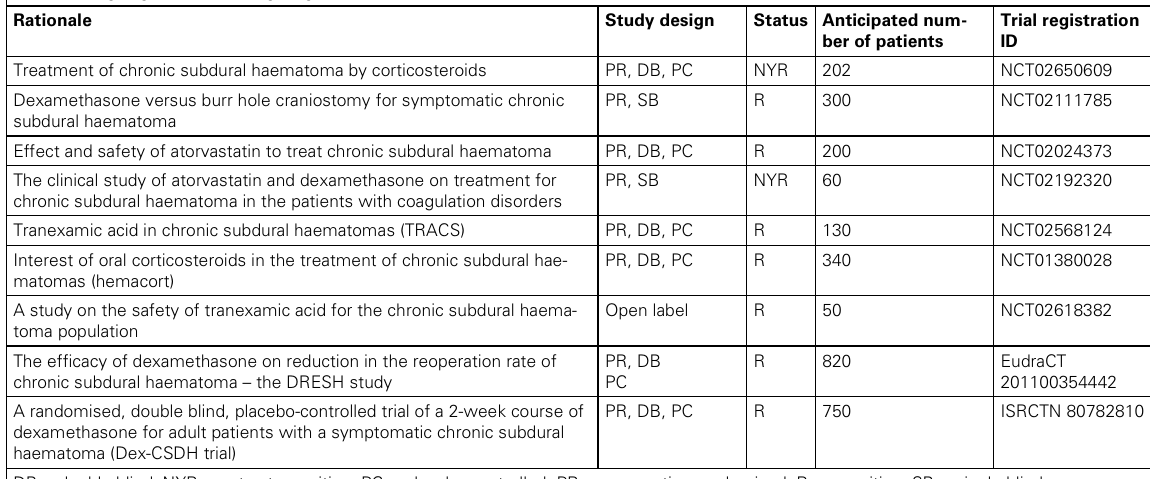
Table 5: Ongoing studies investigating various conservative treatment modalities for chronic subdural haematoma.